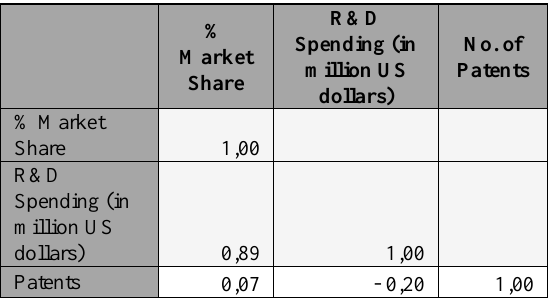
Table 8: Samsun Correlations of Variables